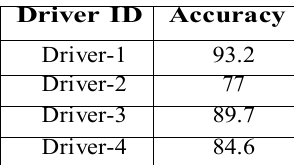
Figure 14. Driver Performance Table 14. Accuracy of prediction by classification model and individual driving